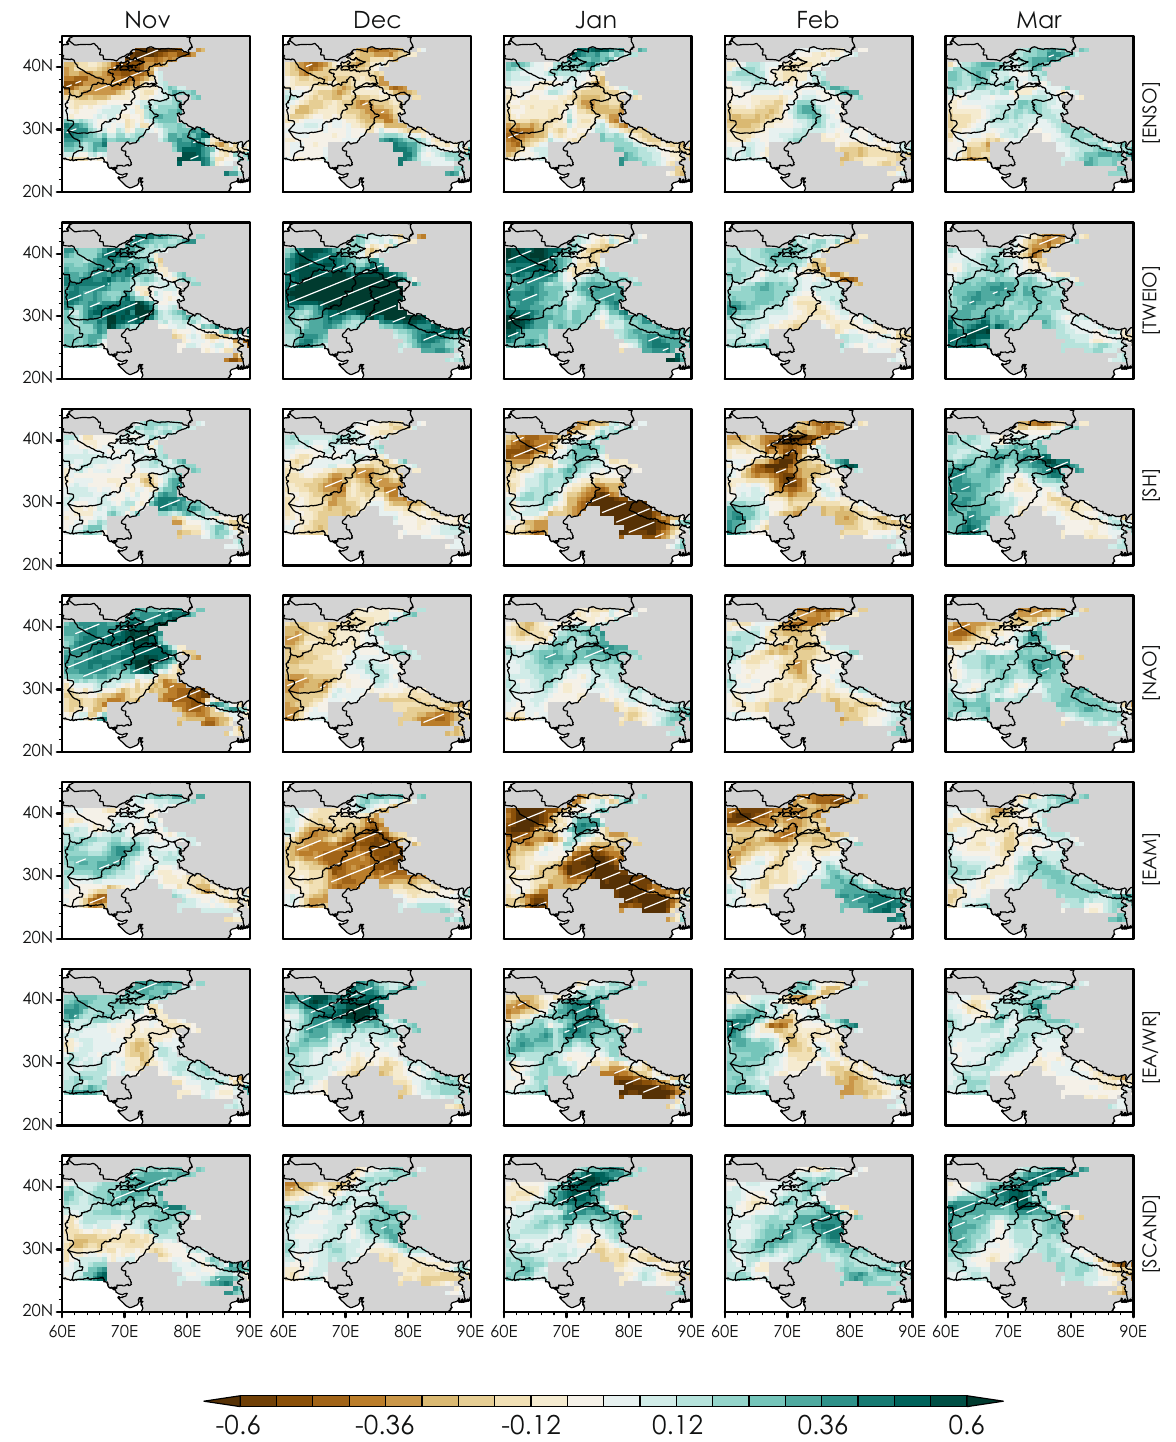
Fig. 4 Monthly standardized partial regression coef fi cients associated with the natural modes of climate variability (independent variables) in the multi-linear regression model. Each coef fi cient describes a monthly standardized anomaly in the total recycled precipitation per unit monthly anomaly in the corresponding standardized natural mode of climate variability while holding all other modes constant. (1st row) ENSO, (2nd row) TWEIO, (3rd row) SH, (4th row) NAO, (5th row) EAM, (6th row) EAWR, (7th row) SCAND. Stippling represents statistical signi fi cance at a 90% con fi dence